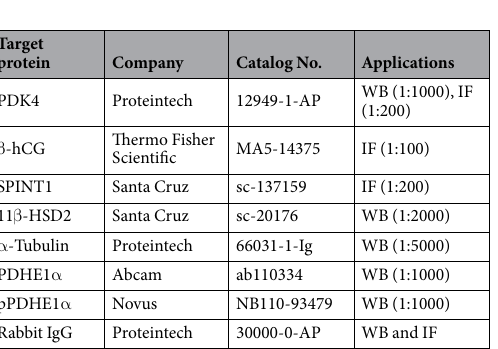
Figure 6. Diagram illustrating the switch from glycolysis to OXPHOS via down-regulation of PDK4 expression upon activation of the cAMP pathway by hCG during syncytialization of the trophoblasts.